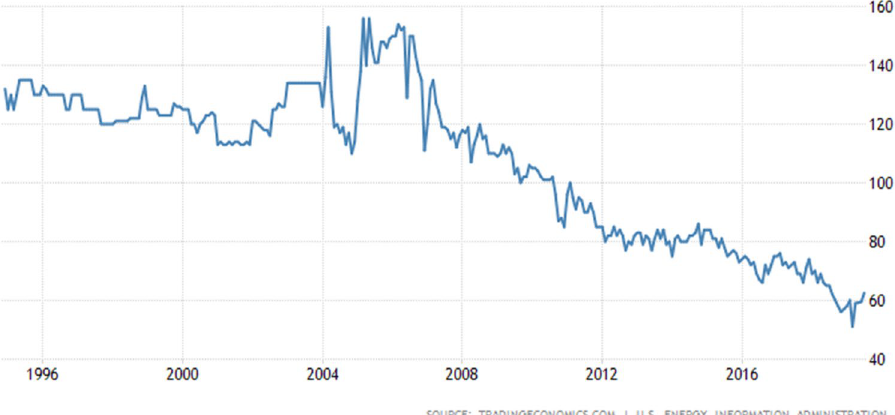
Fig. 1 Crude oil production in Trinidad and Tobago by year from 1994 to 2019 (Source Oil Production vs. Years by Trading